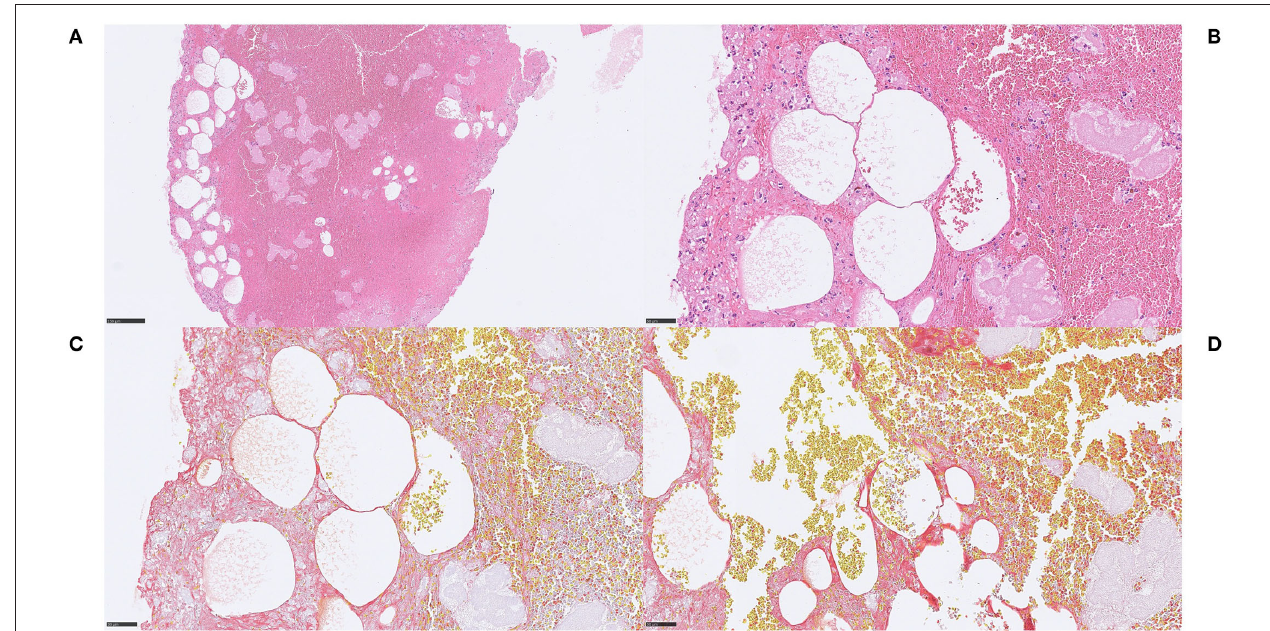
FIGURE 6 | Adipocyte-like structures. Case 3.1 Aggregates of adipocyte-like structures within stroke thrombus (A) , H&E, 100x, some of these structures were juxtapositioned and separated by a very thin eosinophilic membrane-like structure (B) , H&E, 400x. The nature of this finding is not evident but no adipocyte nuclei were detected despite examination of multiple H&E-stained levels. Most adipocyte-like structures were scattered individually without a border structure toward surrounding red blood cells, and the membrane-like structures stained convincingly red on MSB, suggestive of fibrin content and an expansive process (C,D) , MSB, 400x. Immunohistochemical stains with S100 and Annexin were performed on multiple levels although no relevant immunoreactivity was obtained in membrane-like structures, as would have been expected if they were adipocytes (not shown). Some inflammatory cells, predominantly macrophages and some lymphocytes (immunohistochemically verified with CD45 and CD68; not shown) surrounded the spaces. No MNGCs were identified. These findings may suggest that the adipocyte-like structures may represent air emboli, which could have been introduced with repeated cerebral angiographies during the MT, either penetrating the occluding thrombus or incorporated in an occluding but still growing thrombus. Whether this in that case impacted the outcome of the MT is unclear. For 100x, scale bar = 250 µ m; for 400x, scale bar = 50 µ